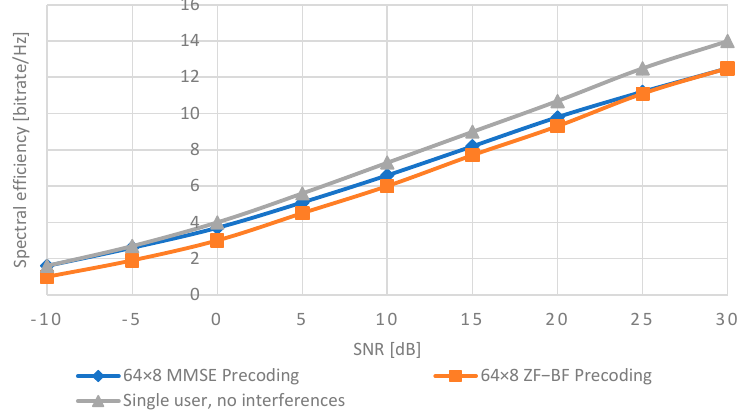
Figure 6. Comparison among ZF-BF and MMSE-BF: Achievable rate varying SNR in the range [ − 10; 30] dB with 64 Tx-antennas and 8 mobile devices covered by the antennas.